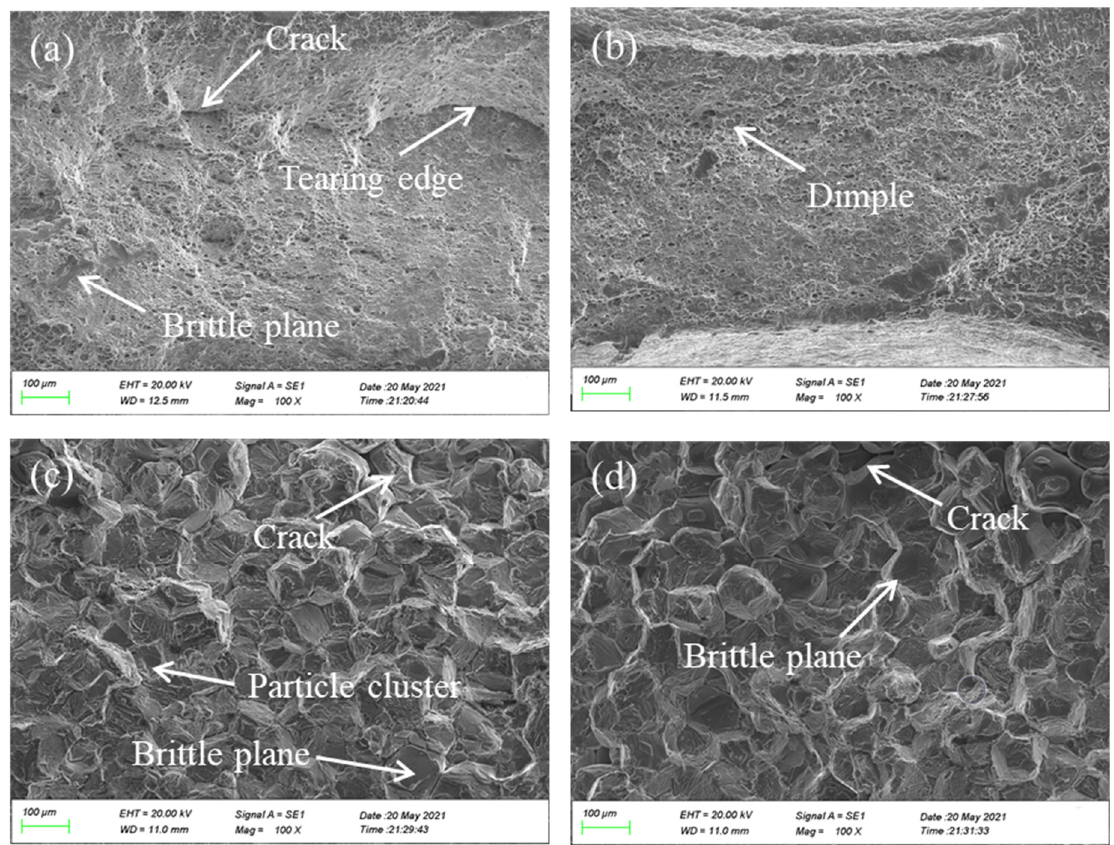
Figure 14. Fractography of 4343/3003/6111/3003 Al clad sheet in various conditions: ( a ) cold-rolled state; ( b ) 330 ◦ C/3 h (annealed state); ( c ) 330 ◦ C/3 h + 610 ◦ C/10 min (brazed state); ( d ) 330 ◦ C/3 h + 610 ◦ C/10 min + 180 ◦ C/8 h (aged